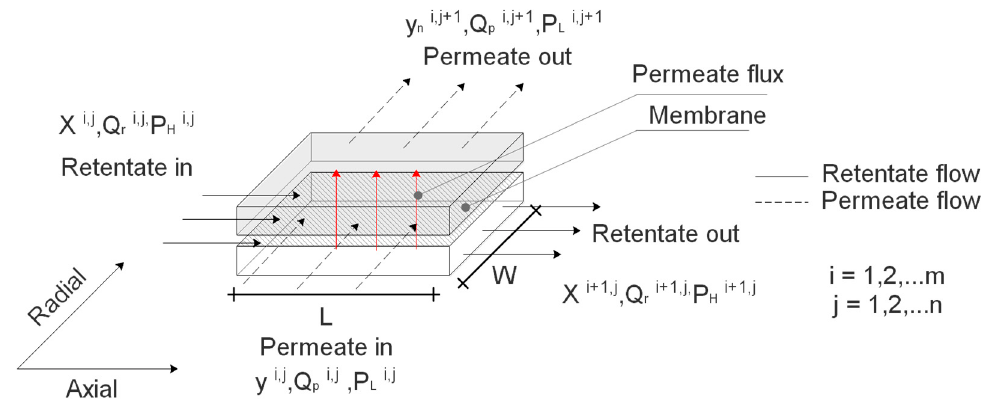
Figure 2. Succession of state approach in an SWM. Figure 3 represents the elemental volume of the cross-flow SWM module elements utilized in the proposed model that is comprised of the feed and permeate sections and membrane layer. The axial direction is represented by the dimension i while the radial direction is represented by the dimension j . The leaf is represented by the dimension k . The components are differentiated in terms of their permeating nature. The fast-permeable component is referred to as x in the retentate stream, while y is the permeable component in the permeate stream.